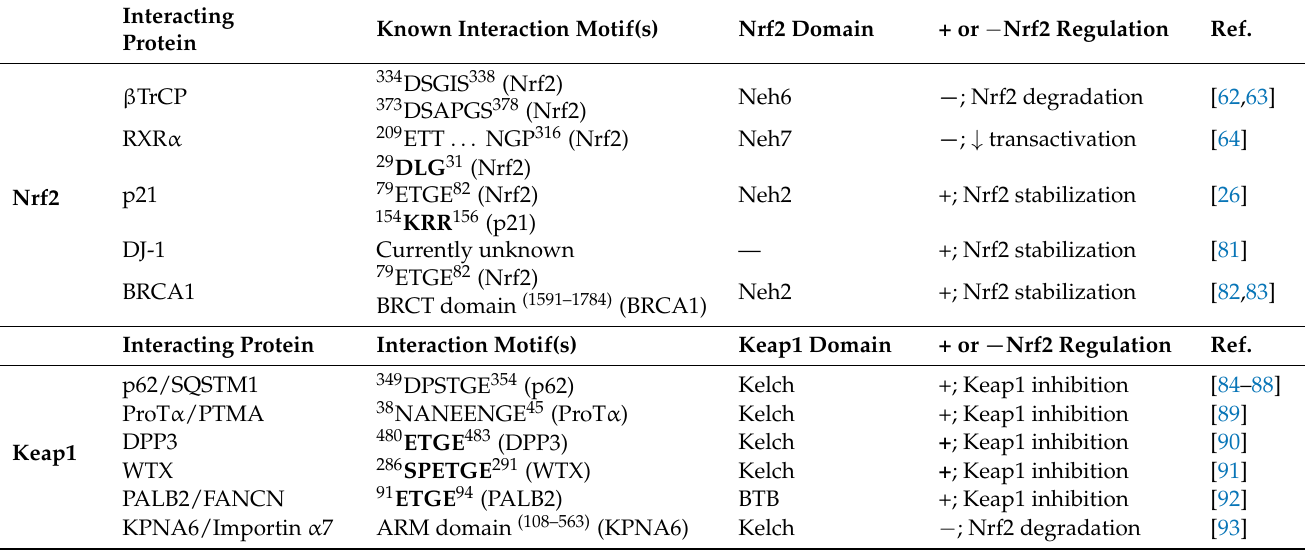
Table 4. Non-canonical Nrf2 regulation by direct protein